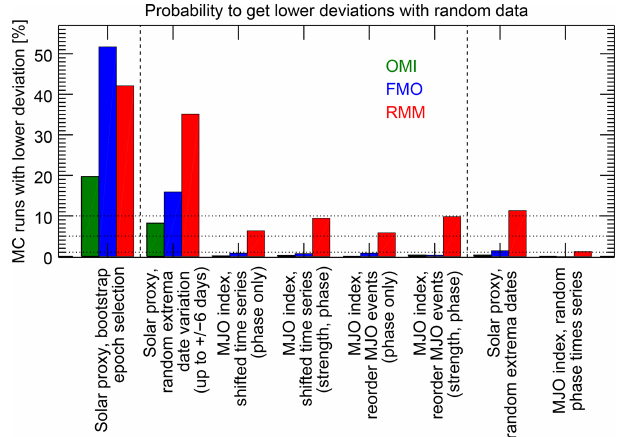
Figure 12. Results of the different MC implementations for the standard experiment setup (QBO easterly, boreal winter, MJO strength threshold 1, and solar minimum trigger), which corre- sponds to the example of Sect. 3. The horizontal dashed lines mark the significance levels of 1%, 5%, and 10%, respectively. The eight items are ordered according to a decreasing conservation of the internal temporal structure by the random modifications. The re- sults are shown for the MJO indices OMI (green), FMO (blue), and RMM (red) for each implementation method. The first and the last two methods, which are separated by dashed lines, are included for completeness but do not really characterize the significance of the experiment; see Sect. 4.5 for